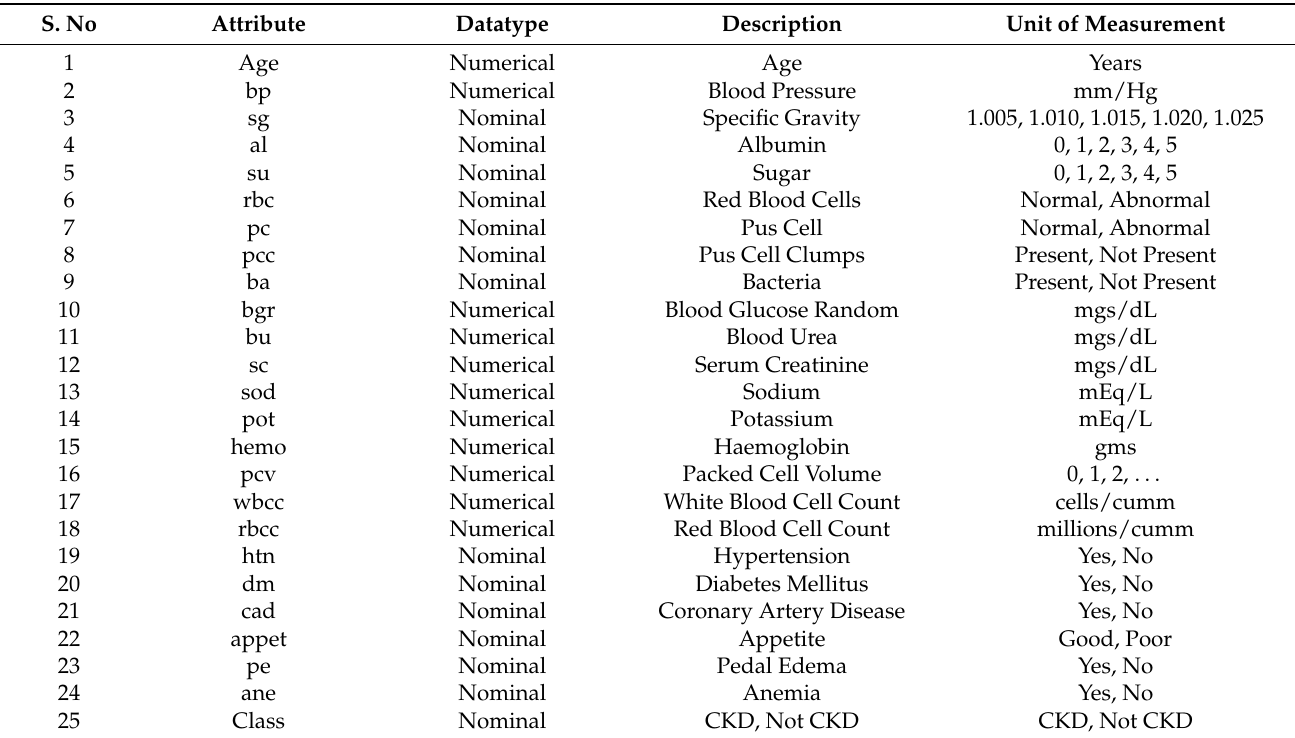
Table 1. Data variables for patients’ CKD dataset